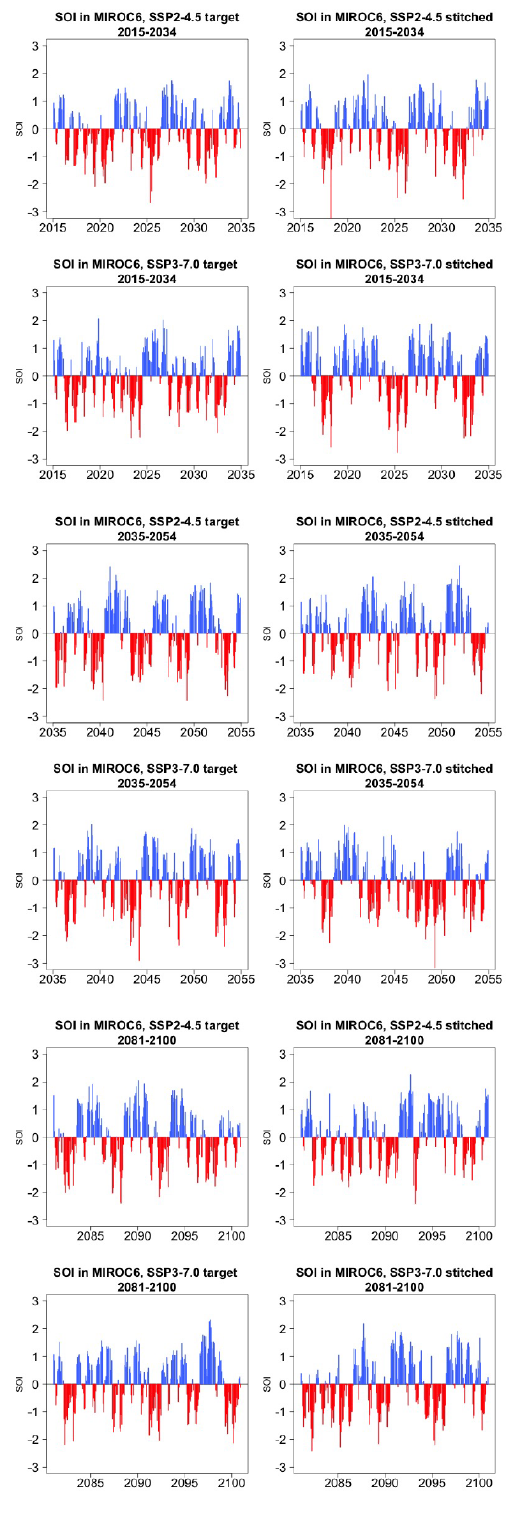
Figure D5. Examples of target (left) and stitched (right) SOI time series for three 20-year windows along the length of the simulation: 2015–2034 in the top four panels, 2035–2054 in the middle four panels, 2081–2100 in the bottom four panels. Results from emulation of SSP2-4.5 and SSP3-7.0 for one of three ensemble members emulated under each scenario for MIROC6.